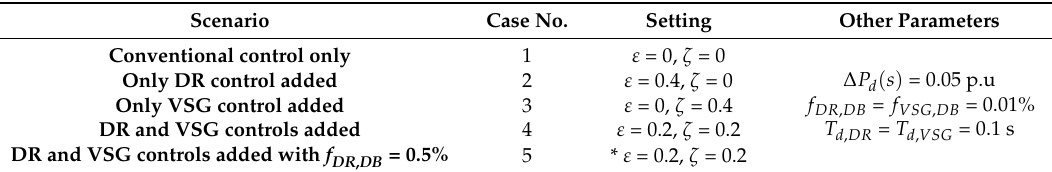
Table 4. DR and VSG control: simulation scenarios and parameter setting.